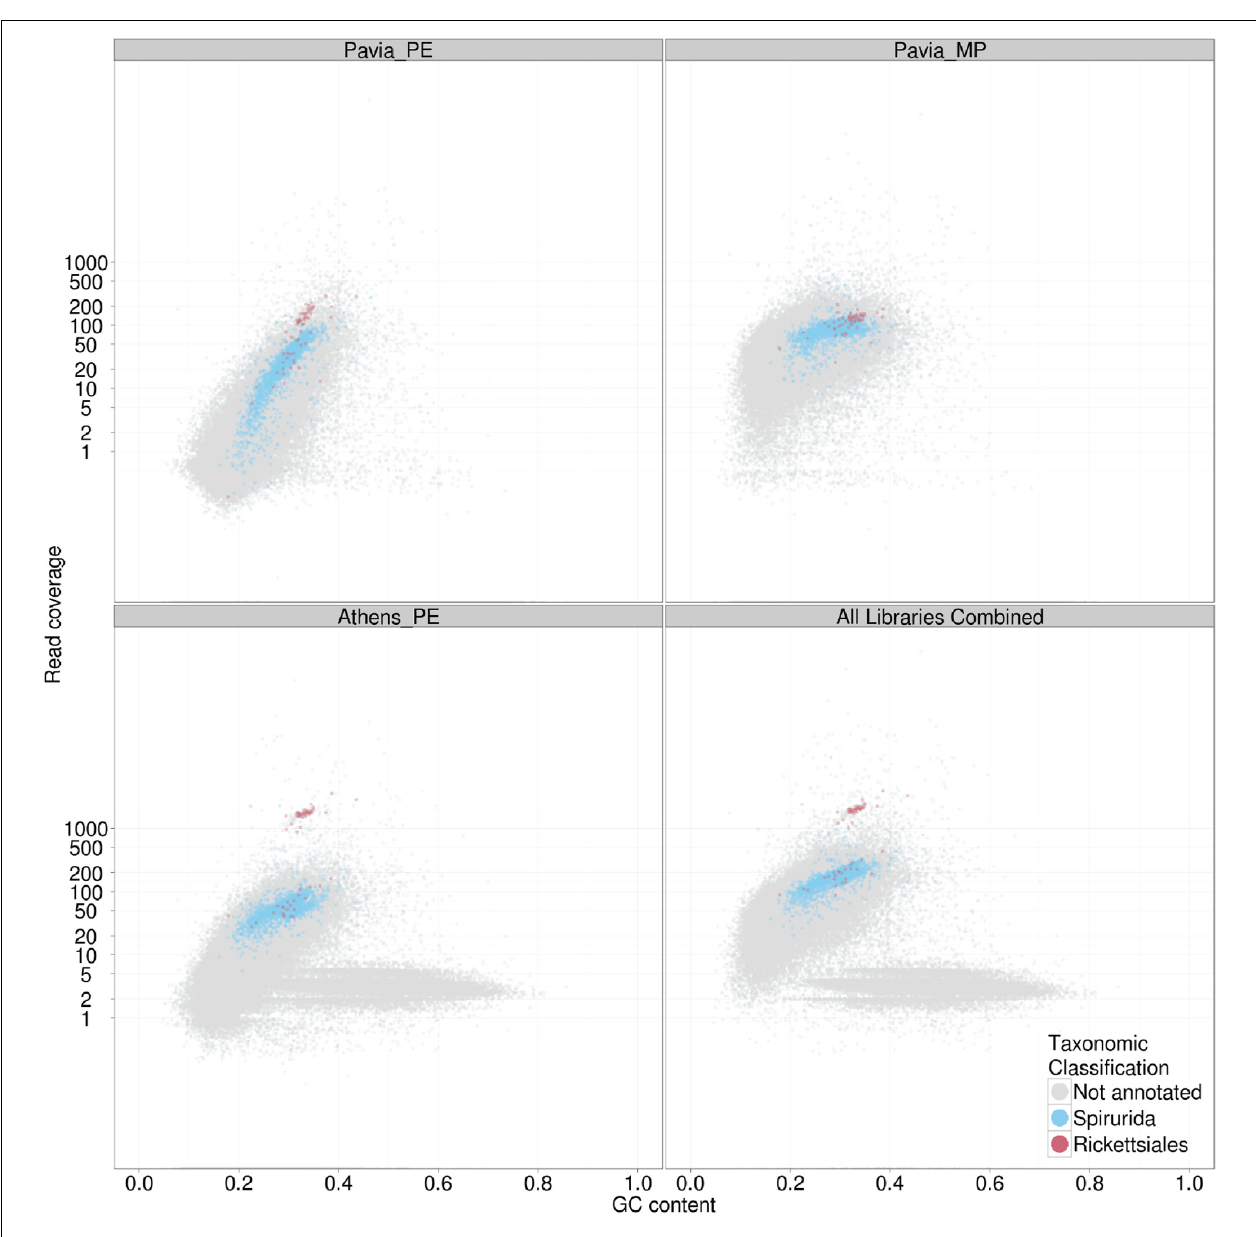
read sets were aligned to an assembly generated from the paired end data. TheTAGC plots were taxonomically annotated, and contigs with best similarity to Spirurida (the order to which D. immitis belongs) and Rickettsiales (the alphaproteobacterial order to which Wolbachia belongs) were highlighted in color. Other conventions as in Figure 2